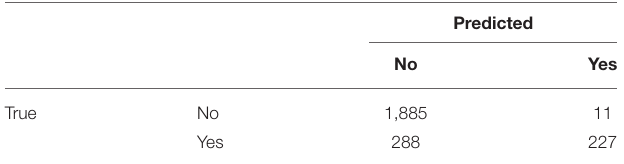
TABLE 3 | Confusion matrix for the CatBoost without balancing method